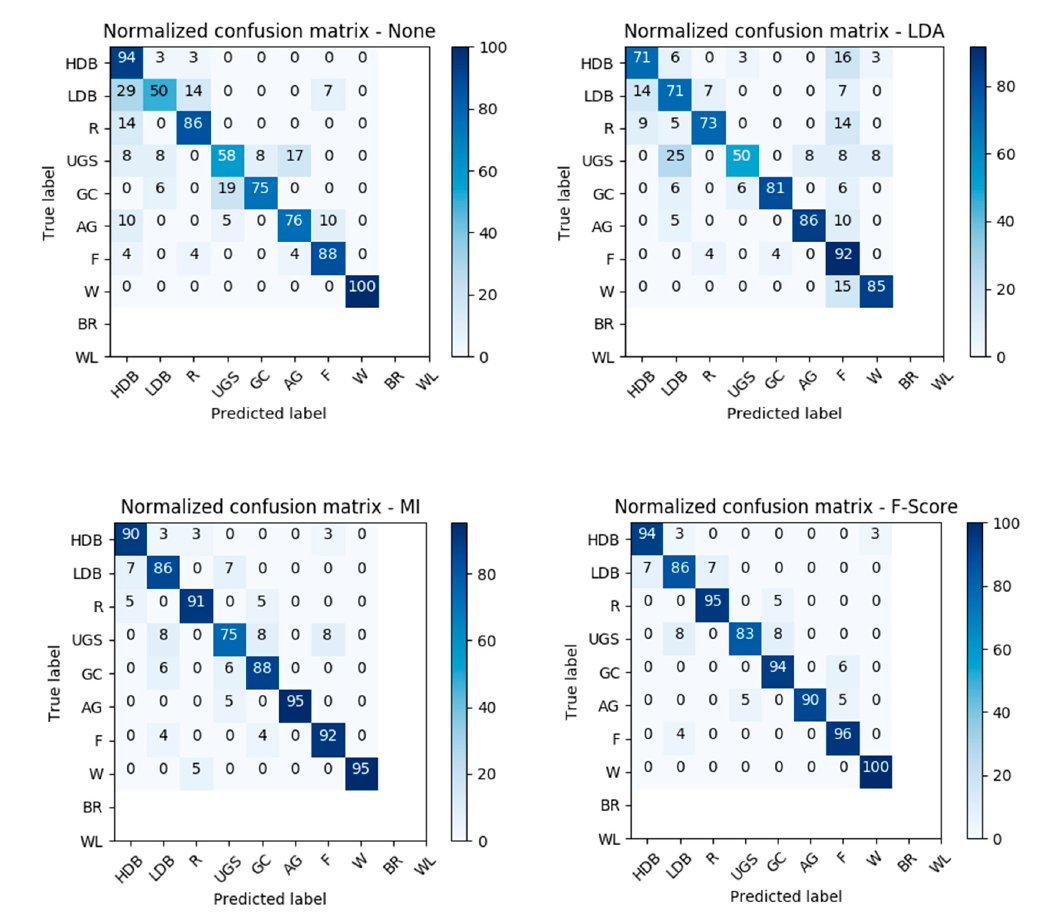
Figure 12. Normalized confusion matrices of the predictions on testing data